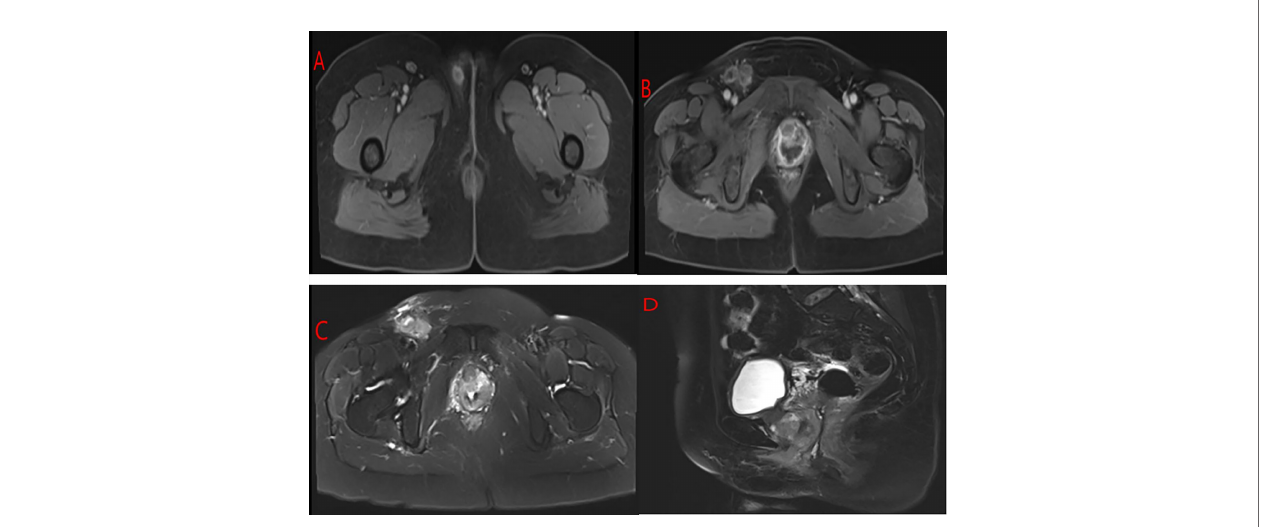
FIGURE 2 | MRI of the pelvis of the patient. (A) A mass in the right labia majora. (B, C) The right inguinal area showed swelling, multiple lymphadenopathies, and a mass in the anterior vaginal wall that surrounded the urethra and grew in a semi-encircled manner. (D) The mass in the anterior wall of the vagina was suspected to invade the urethra but only. Surrounded the urethra.